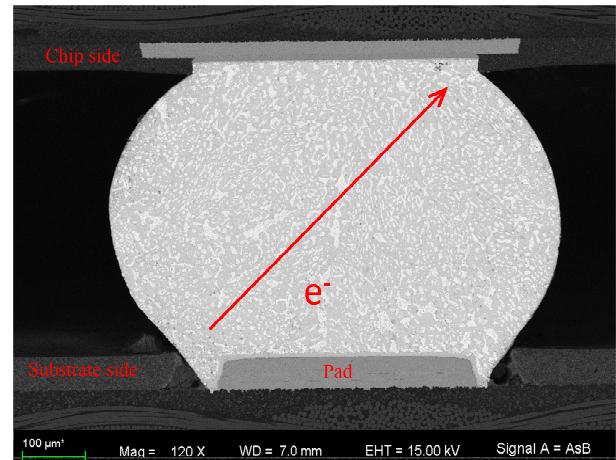
Figure 4. An SEM image of a BGA.